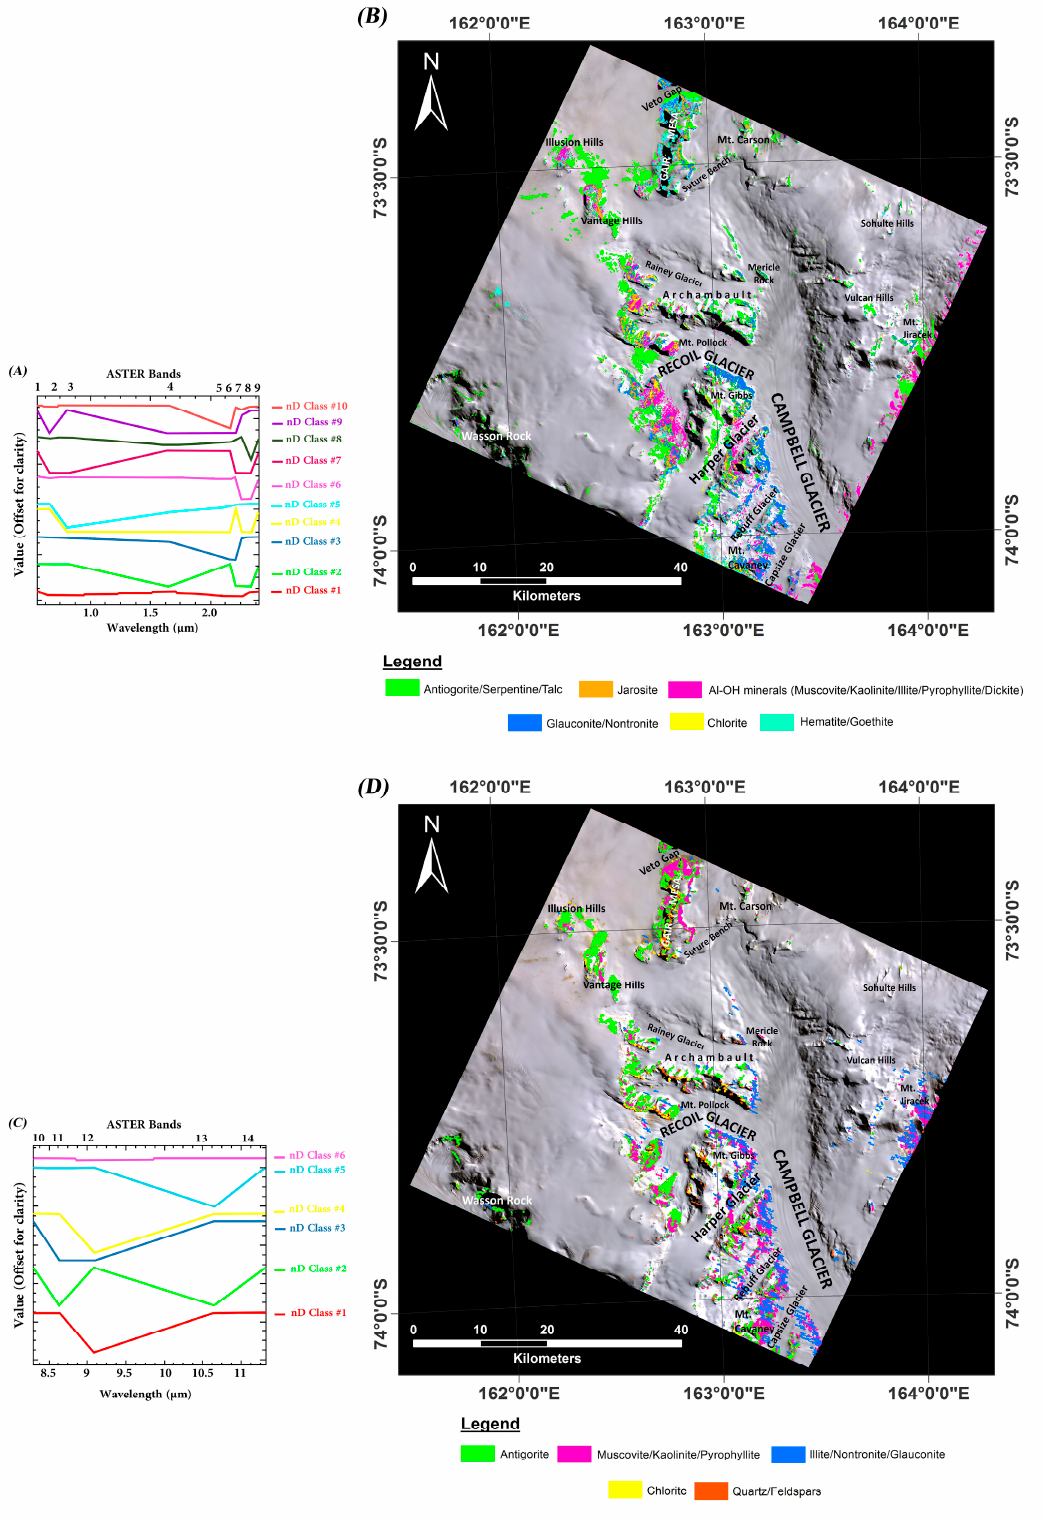
FIG 6 Figure 6. ( A ) Endmember spectra extracted from ASTER VINR+SWIR bands using the n-Dimensional analysis technique for the Campbell Glacier (I). ( B ) MTMF classification mineral maps derived from MF score images (VINR+SWIR bands) for the Campbell Glacier (I) scene. ( C ) Endmember spectra extracted from ASTER TIR bands using the n-Dimensional analysis technique for the Campbell Glacier (I). ( D ) MTMF classification mineral maps derived from MF score images (TIR bands) for the Campbell Glacier (I)